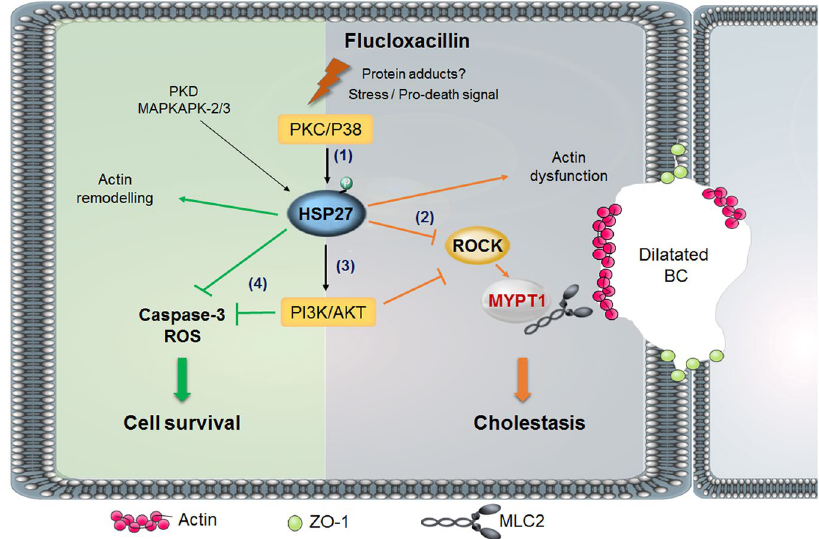
Figure 9. Schematic representation of sequential molecular mechanisms involved in FLX-induced cholestasis. FLX induces phosphorylation of HSP27 through activation of PKC/P38 (1). Activated p-HSP27 plays a central role in cholestasis; it inhibits ROCK and consequently MYPT1 phosphorylation leading to BC dilatation and cholestasis (2) and activates PI3K/AKT leading to BC dilation and cholestasis through MYPT1 dephosphorylation (3). In parallel to cholestatic insult, activated p-HSP27 could lead to cell resistance and survival through PI3K/AKT pathway activation preventing caspases induction and ROS generation (4). ROCK, Rho-kinase; MLC2, myosin light chain 2; MYPT1, myosin phosphatase target subunit 1; BC, bile canaliculi; ZO-1, zona occludens-1 protein; PKC, protein kinase C; P38, p38 mitogen-activated protein kinase; PI3K, phosphoinositide 3-kinase; AKT, protein kinase B; HSP27, heat shock protein 27; PKD, protein kinase D; ROS, reactive oxygen species; MAPKAPK, mitogen-activated protein kinase-activated protein